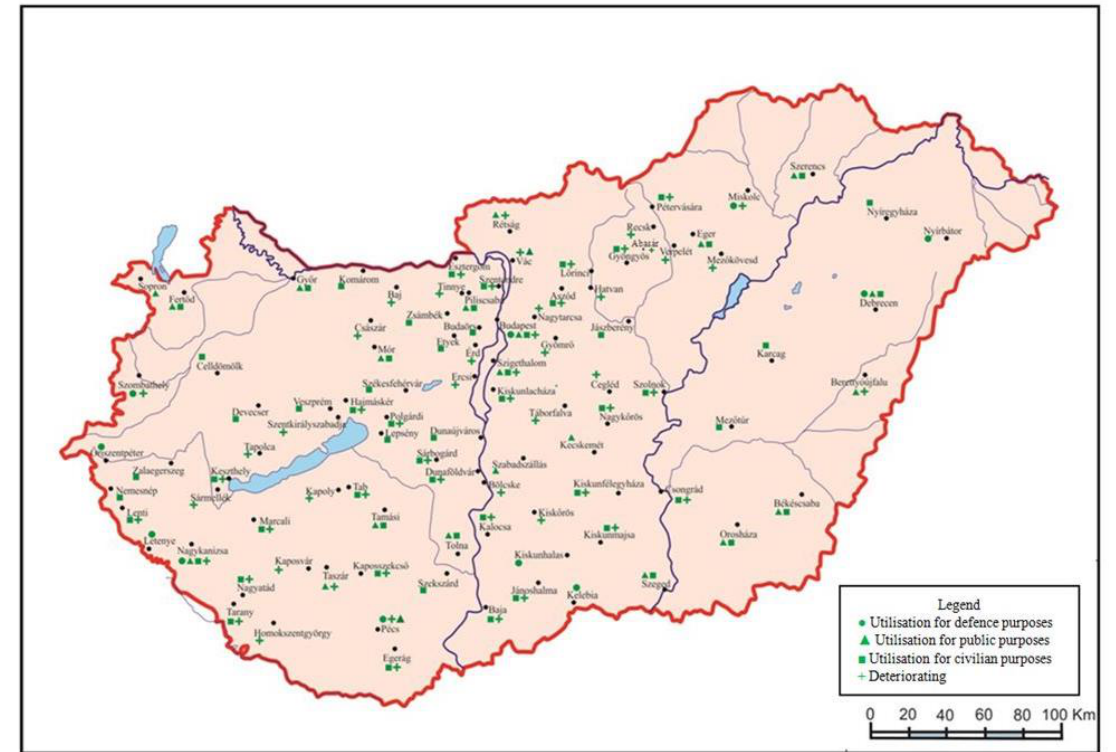
Fig. 1. Type of utilization of baracks visited by the author (Source: own survey,